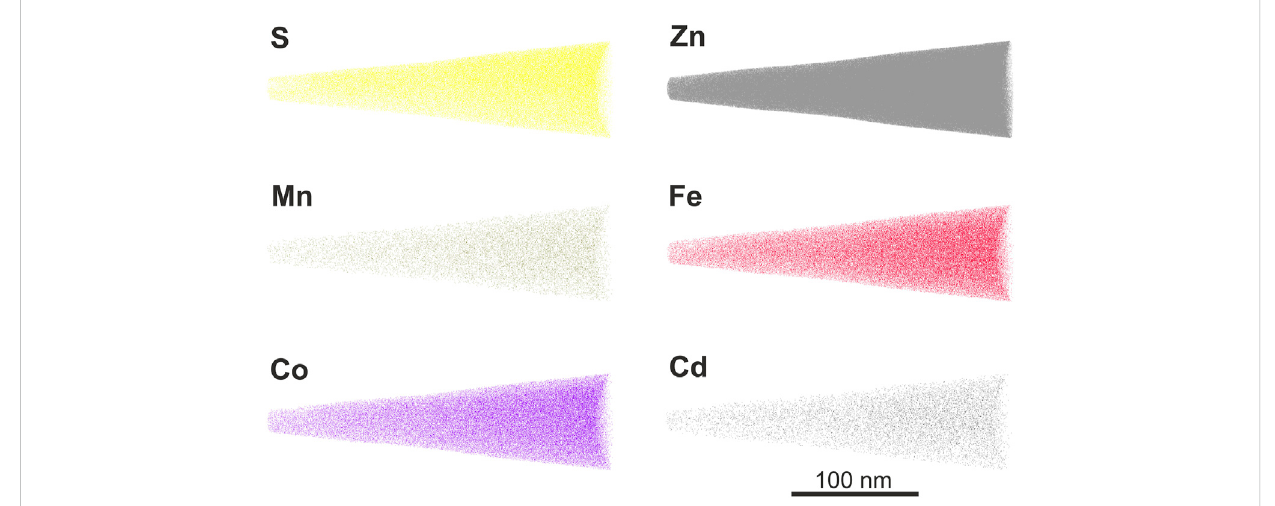
FIGURE 5 APT data reconstruction of Co-rich sphalerite needle-shaped specimens, showing S, Zn, Mn, Fe, Co, and Cd ions.